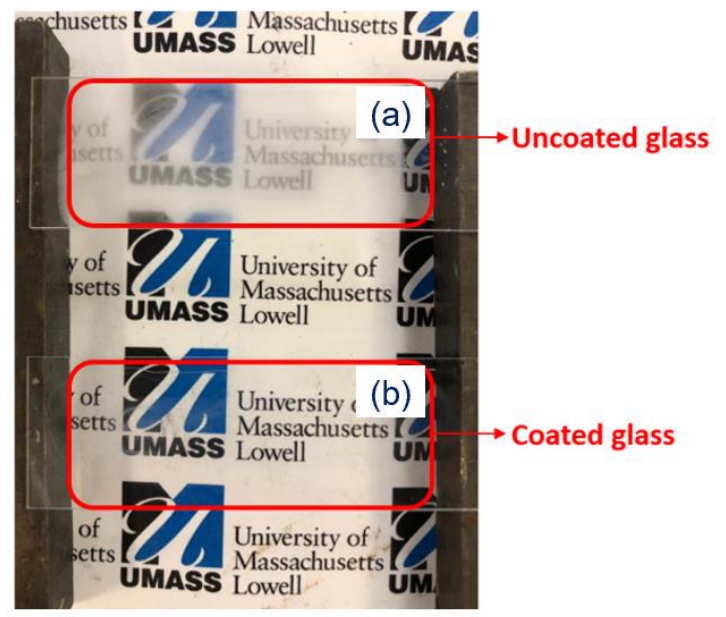
Figure 9. ( a ) uncoated glass, ( b ) SS6 coated glass.